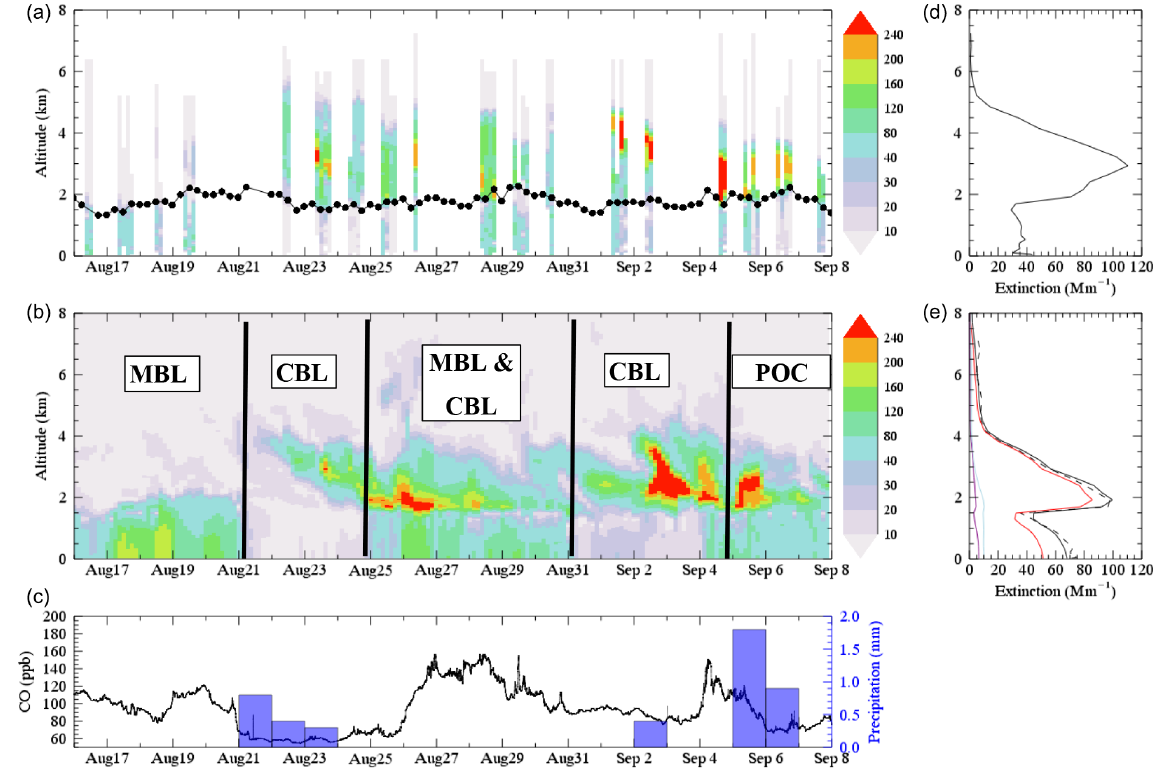
Figure 9. Time series plots. (a) Vertical profiles of the submicron aerosol extinction ( × 10 − 6 m − 1 ) derived from the EXSCALABAR instru- ment (405nm, dry), with radiosonde estimates of the MBL inversion height overlaid with black circles. A mean vertical profile of aerosol extinction is also shown in (d) . (b) Vertical profiles of aerosol extinction ( × 10 − 6 m − 1 , 405nm, dry) from the Met Office CLUMP forecast model; MBL and CBL and POC are used to discriminate the vertical profile regimes described in Table 2. Panel (e) shows the mean profile of BBA aerosol only in red; industrial aerosol is shown in cyan and mineral dust in blue. The solid and dashed black lines show the mean aerosol profile (dry) and the mean profile (subsampled when there were FAAM flights) for all CLUMP aerosol components. (c) The carbon monoxide (CO) concentrations measured at the AMF on Ascension Island at ∼ 330ma.s.l. in the MBL, with precipitation measured at the Met Office on Ascension Island